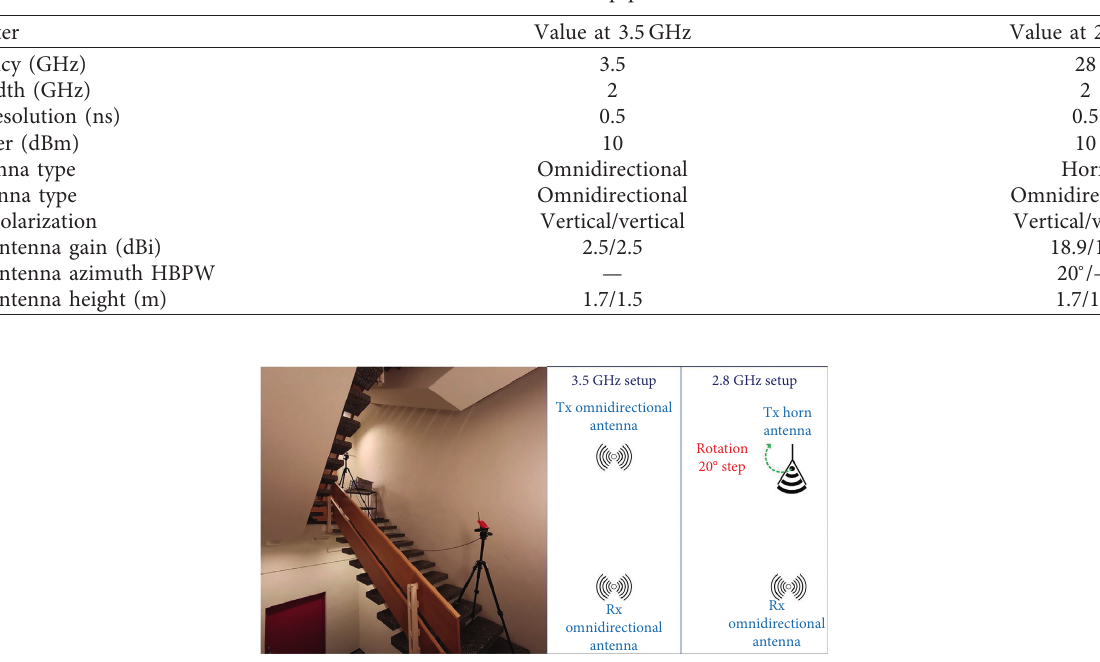
Table 1: Measurement setup parameters.